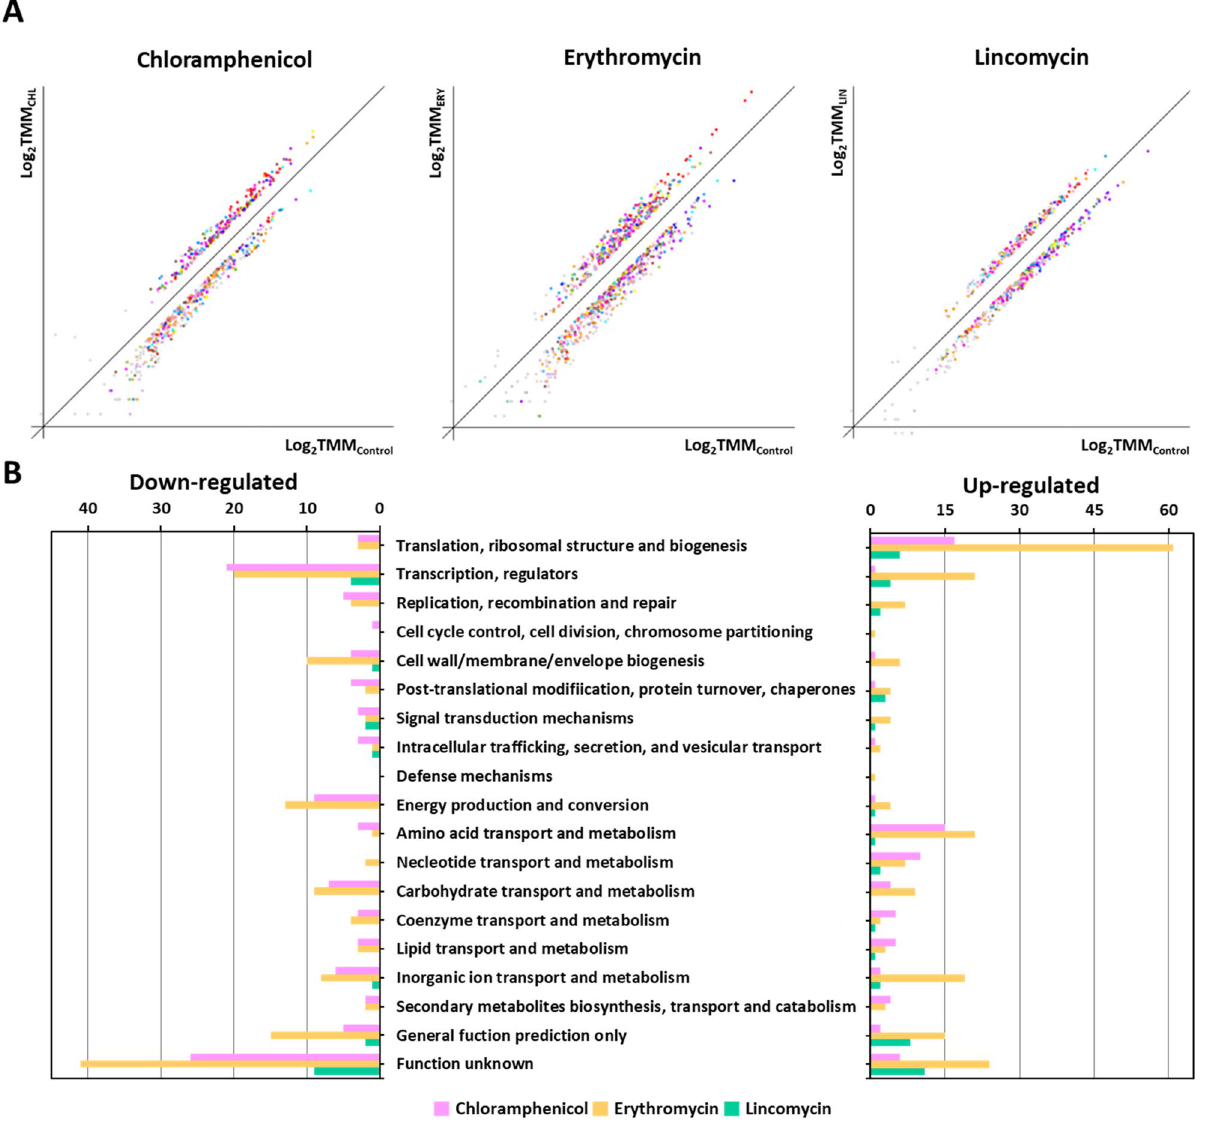
Figure 1. Classification of differentially expressed genes (DEGs) based on predicted functions. ( A ) DEG analysis from RNA-Seq data comparing untreated Staphylococcus equorum strain KM1031 with strain KM1031 treated with antibiotics. The x -axis shows log-scaled Trimmed Mean of M -value (TMM) data for strain KM1031, and the y -axis shows log-scaled TMM values for cells treated with chloramphenicol, erythromycin, and lincomycin, respectively. Total gene expression in the two conditions was filtered to identify significantly down- or upregulated genes with the criteria P-value ≤ 0.05 and fold-change ≥ 2. ( B ) Genes upregulated or downregulated by twofold or more following treatment of the bacterium with antibiotics were grouped into functional categories based on the Clusters of Orthologous Groups that Msr gives rise to erythromycin resistance via an active transport process 21 . Collectively, these findings strongly suggest that the antibiotic ABC transporter ATP-binding protein-coding gene (AWC34_RS11115) con- fers erythromycin resistance in strain KM1031. Chloramphenicol- and lincomycin-specific response genes were not identified among DEGs. Therefore, we conclude that most commonly up- and downregulated genes under antibiotic pressure are associated with general environmental responses, and not responses to chloramphenicol, erythromycin, and/or lincomycin specifically. We hypothesized that antibiotic exposure might increase the expression of genes that are specifically related to antibiotic resistance (i.e., that encode proteins that are involved in the molecular-level resistance of the bac- teria to the drug). Thus, we took the set of genes that were upregulated in S. equorum strain KM031 (not DEGs) in response to any of the antibiotics and subtracted genes detected in the two C S E S L S strains. This left 65 strain KM1031-specific genes (Table 1). The msr (AWC34_RS11115) gene was among them. In a previous study, we suggested that an antibiotic biosynthesis monooxygenase-encoding gene ( abm AWC34_RS01805)